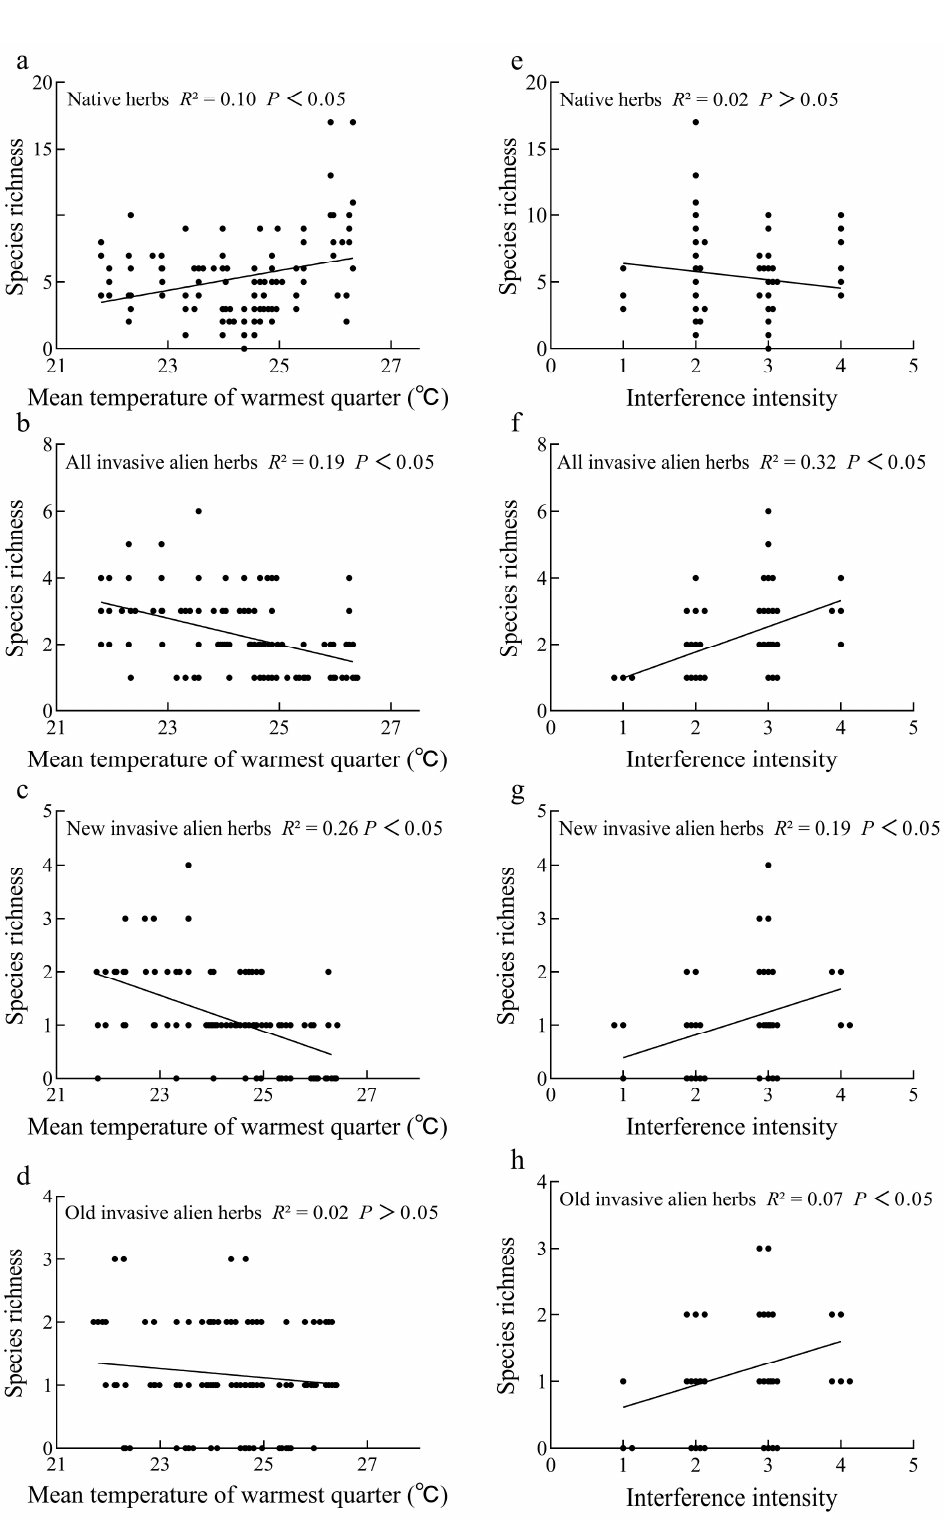
Figure 5. Distribution of richness for ( a , e ) native herbs, ( b , f ) all invasive alien herbs, and ( c , g ) new and ( d , h ) old invasive alien herbs with the mean temperature of the warmest quarter and interference intensity in the Dayao Mountain Reserve.